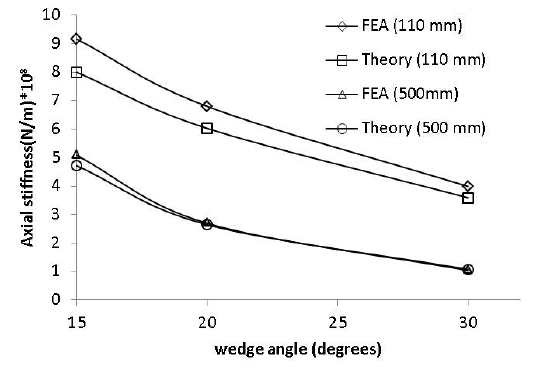
Figure 19: Axial stiffness for a range of wedge angles using both theory and finite element (T-bolt load =6 kN)